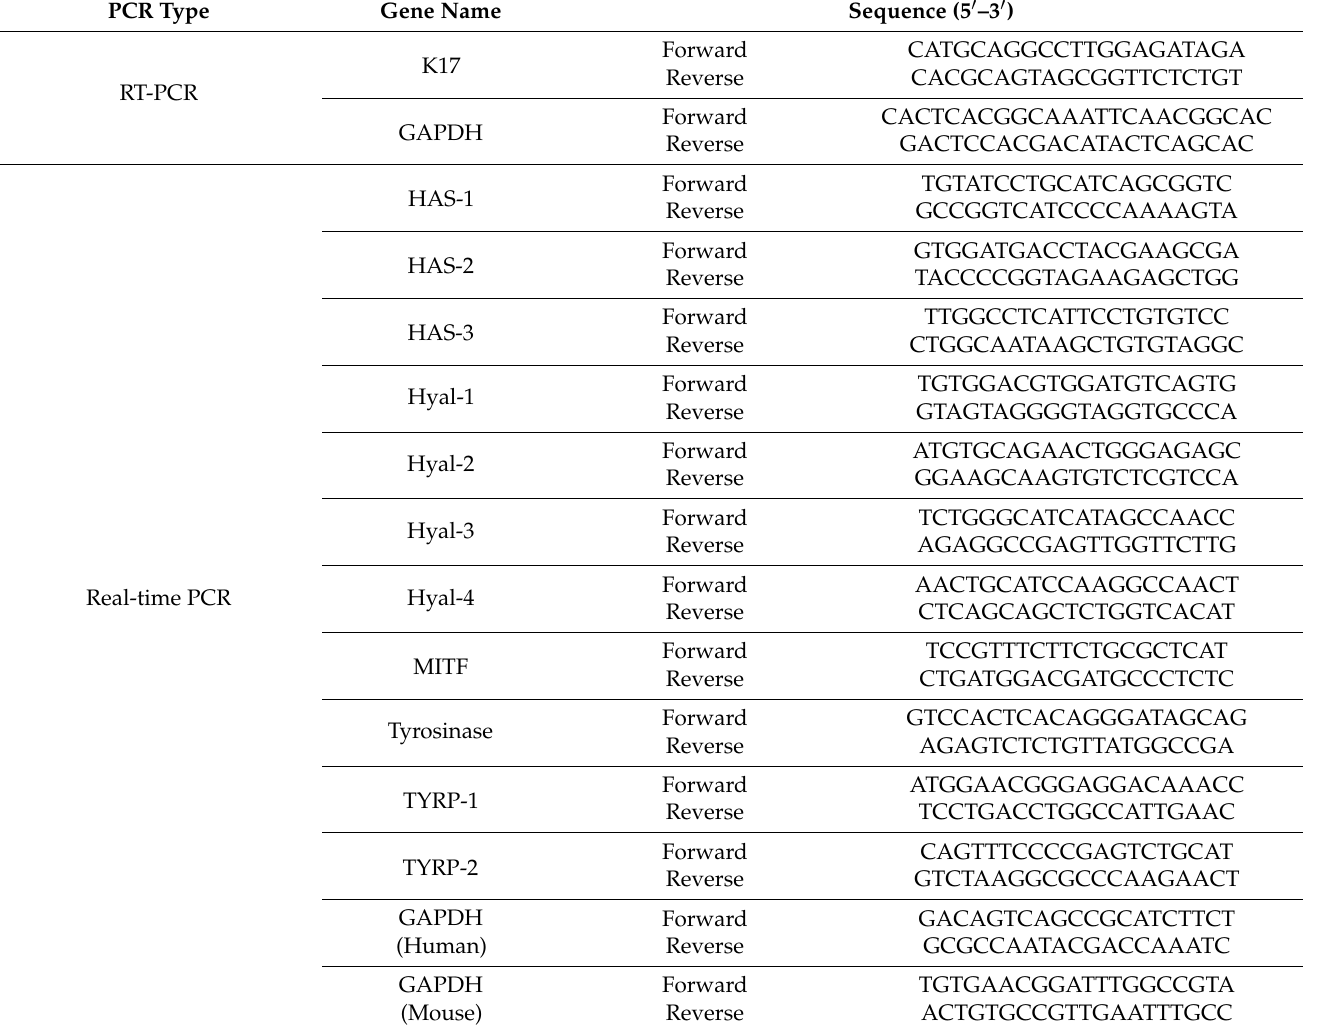
Table 3. Sequences of primers used for